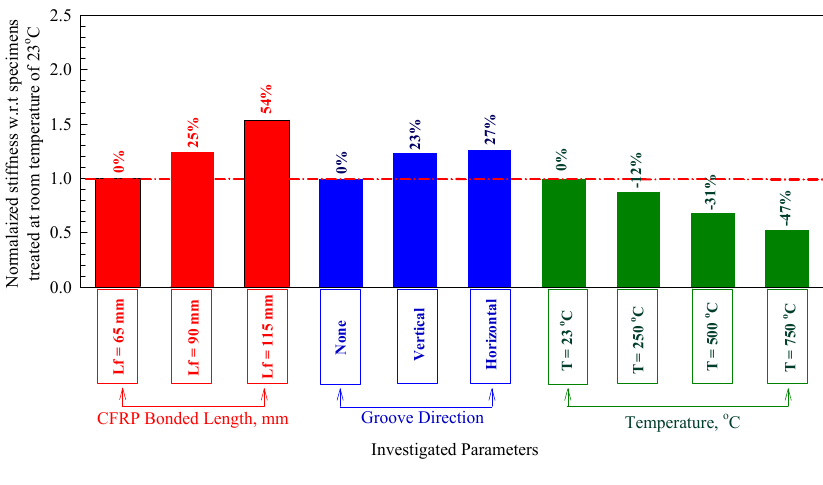
Figure 8. Normalized stiffness.